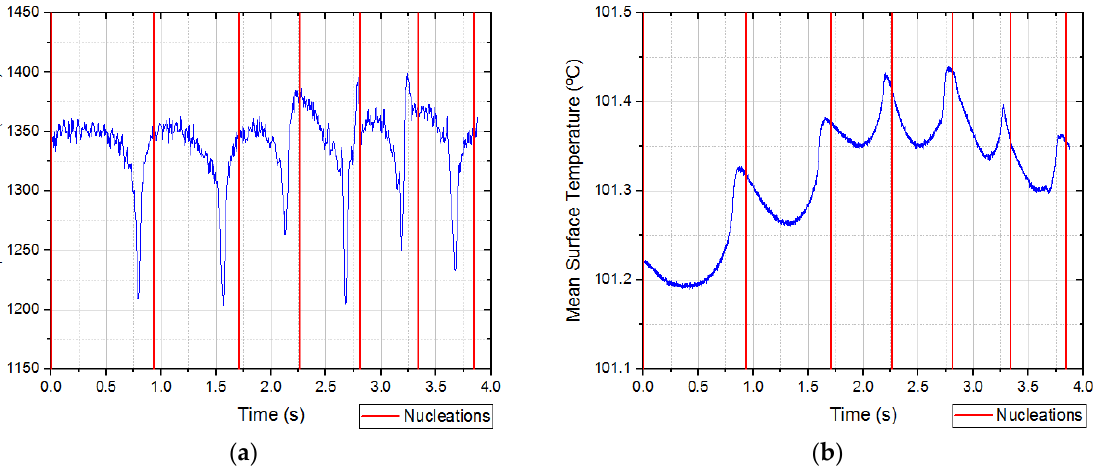
Figure 3. Temporal evolution of the: ( a ) dissipated heat flux, ( b ) mean surface temperature. The interest area has a diameter of 3 mm, the fluid is water, and the imposed heat flux is 1290 W/m 2